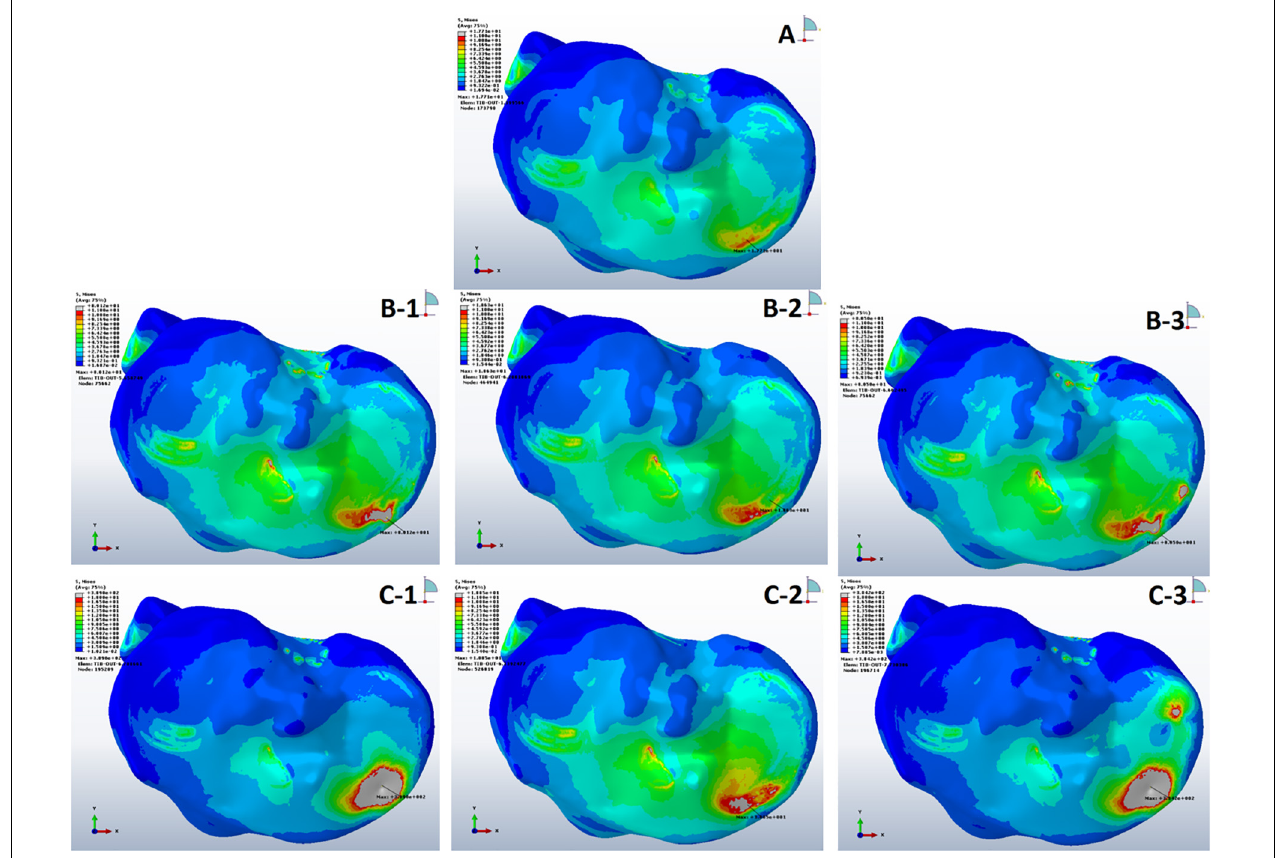
FIGURE 3 | Von Mises stress distribution in subchondral bones during single-leg stance (750 N). (A) Non-cystic knee model. Groups B and C (represented by letters B,C ) with the corresponding sub-groups 1, 2, and 3.